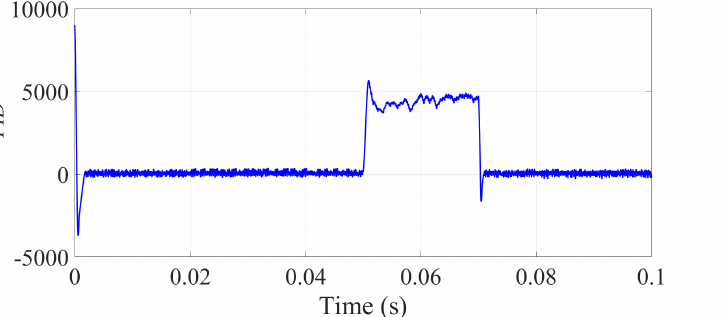
Figure 9. Scenario 1: Control input to generate the duty cycle of a PWM signal using a classical PID controller (simulation 2).